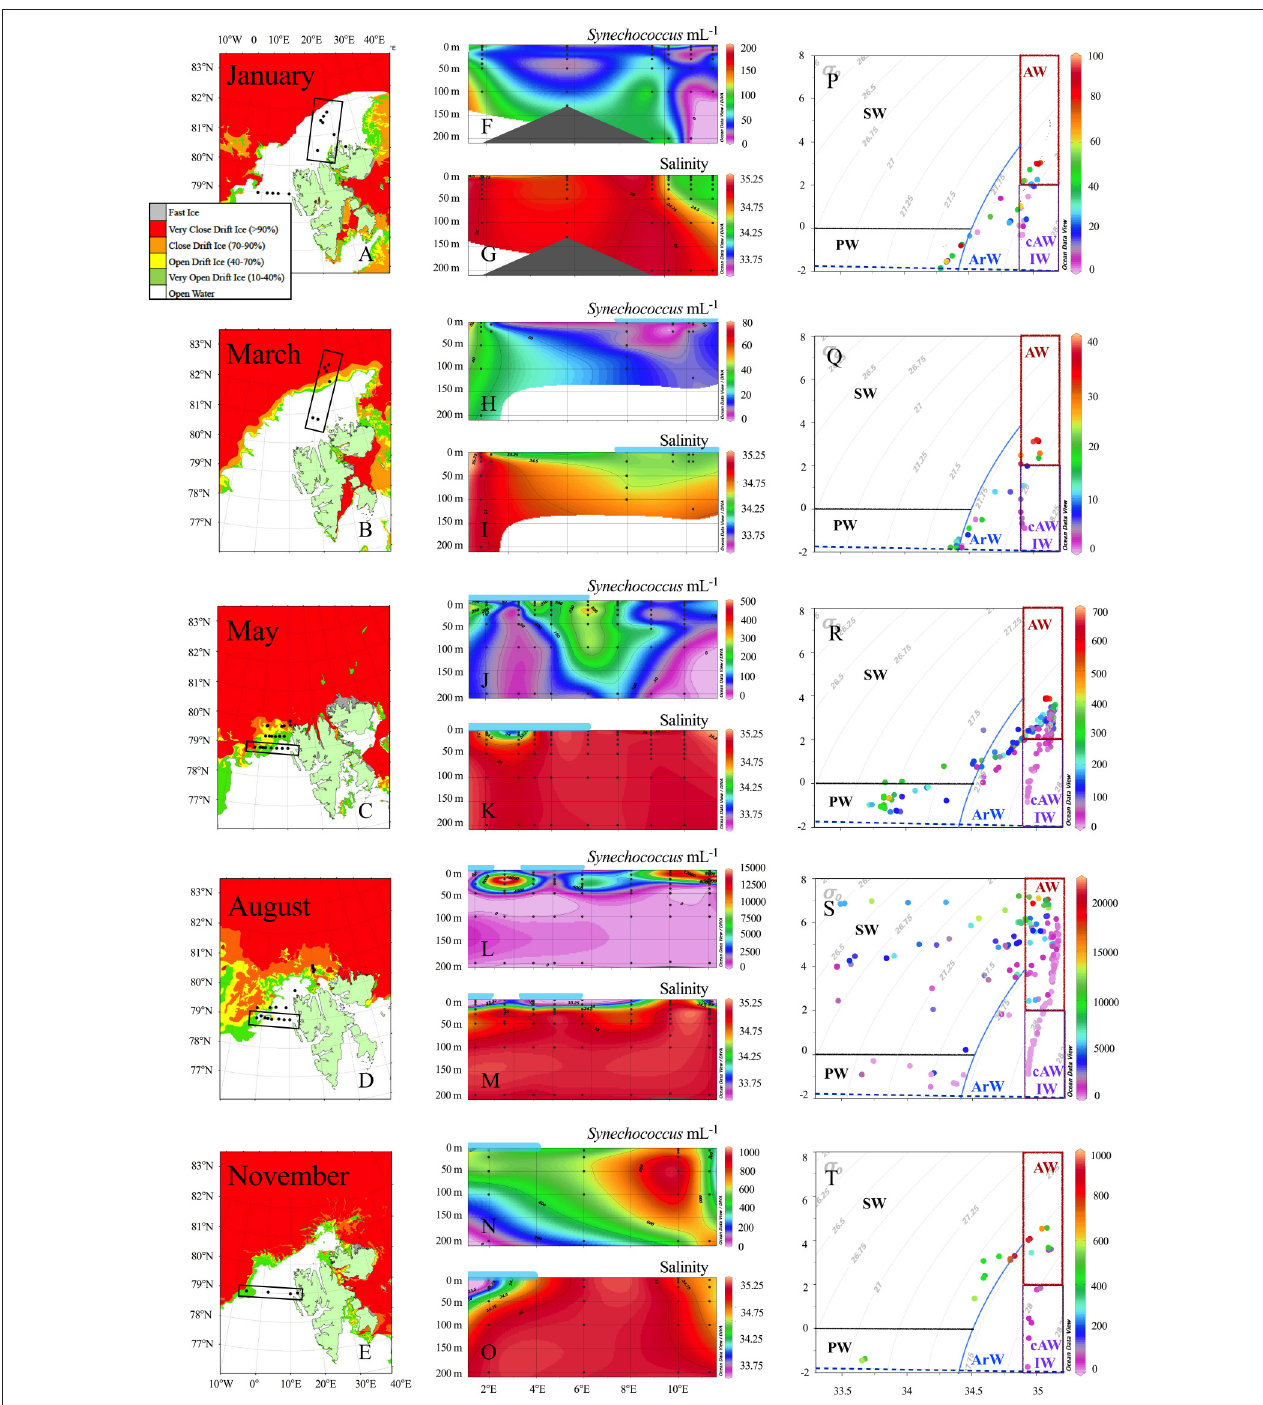
FIGURE 3 | (Left panel) Ice-maps provided from the Norwegian Meteorological Institute (istjenesten@met.no) from following dates; January 10, March 7, May 23, August 12, and November 7, 2014. Transects shown in the middle panel as contour plots are marked with black boxes. (Middle panel) Contour plots showing the abundance (cells mL − 1 ) of Synechococcus and salinity of the upper 200m from 4 cruises. January transect stretches from North-South between 15 and 20 ◦ E, while the remaining transects expands West-East (2–11 ◦ E) following the 79 ◦ N latitude isoline (see transect marked in boxes left of plots). The horizontal light blue lines above the plots roughly mark the cover of open drift ice. Note different scales for Synechococcus abundance. (Right panel) Potential temperature and salinity (TS) diagram for each month. Data included for all depths 1–1000 m. Synechococcu s abundance is given on the z-axis by color gradient (N.B. different scales). Potential density ( σ 0 , kg/m 3 ) isolines overlaid with gray and the surface freezing line is show in dashed blue. Following water masses ( Table 1 ) are marked: Atlantic water (AW), cold Atlantic water or Intermediate water (cAW or IW), which consist mainly of deep water samples ( > 500 m), Arctic water (ArW), surface water (SW) and Polar water (PW).